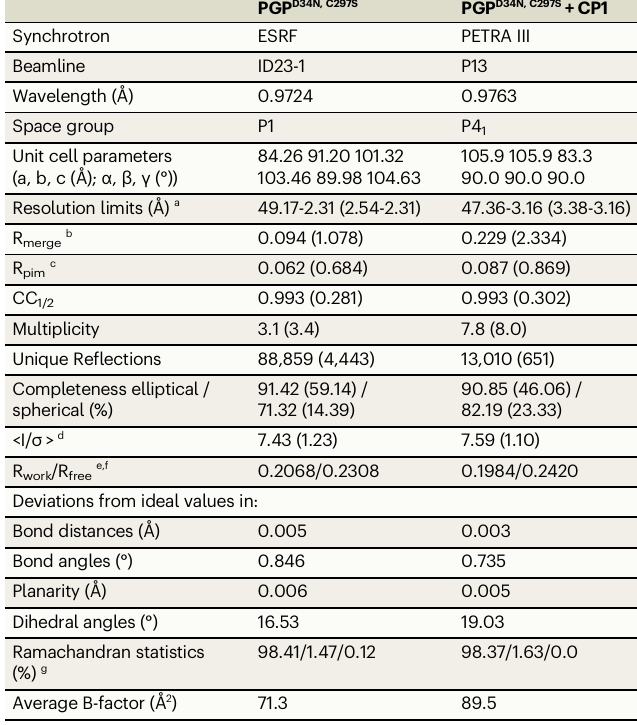
Table 1 | Data collection and re fi nement